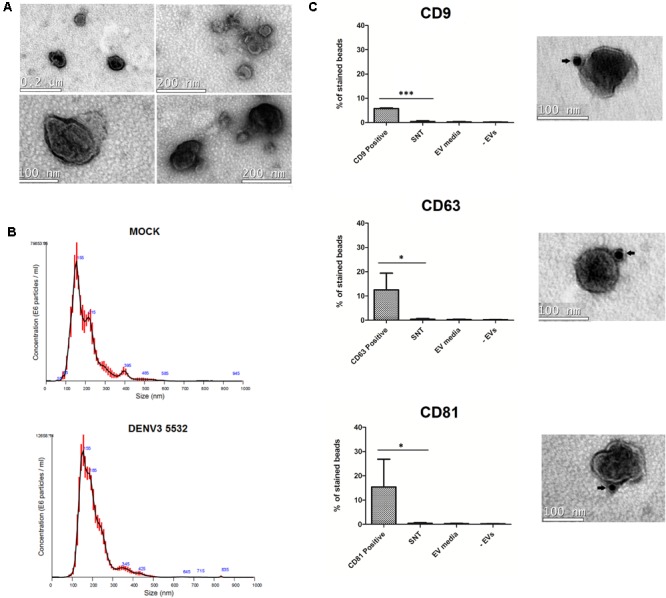
Characterization of mdDC derived extracellular vesicles. (A) Vesicles secreted in mdDC culture supernatants have 30–180 nm and present the characteristic cup shaped morphology of EVs. (B) Size distribution analysis of EVs from Mock and DENV3-5532 infected cells (MOI 10, 72 h). Most of the vesicles have a distribution range around 100 nm, as described before for EVs. Red lines are an average distribution of five measurements. (C) mdDC derived EVs express the tetraspanins CD63, CD81, and CD9 on its surface. The antibody staining with gold particles is indicated by arrows. These markers are also detected on mdDC derived EV populations by flow cytometry, using three pools of samples of three different mdDC donors each (nine samples total), and not detected in three different negative controls. mdDC EVs: EVs from mdDCs infected with DENV3-5532, MOI 10, 72 h; SNT: negative control – ultracentrifugation supernatants after EV pelleting; EV media: negative control – “EVs” isolated from unconditioned media; –EVs: negative control, beads processed the same way as samples, without incubation with EVs. Statistical analysis: one way anova (∗P < 0.05, ∗∗P < 0.01, ∗∗∗P < 0.0001).